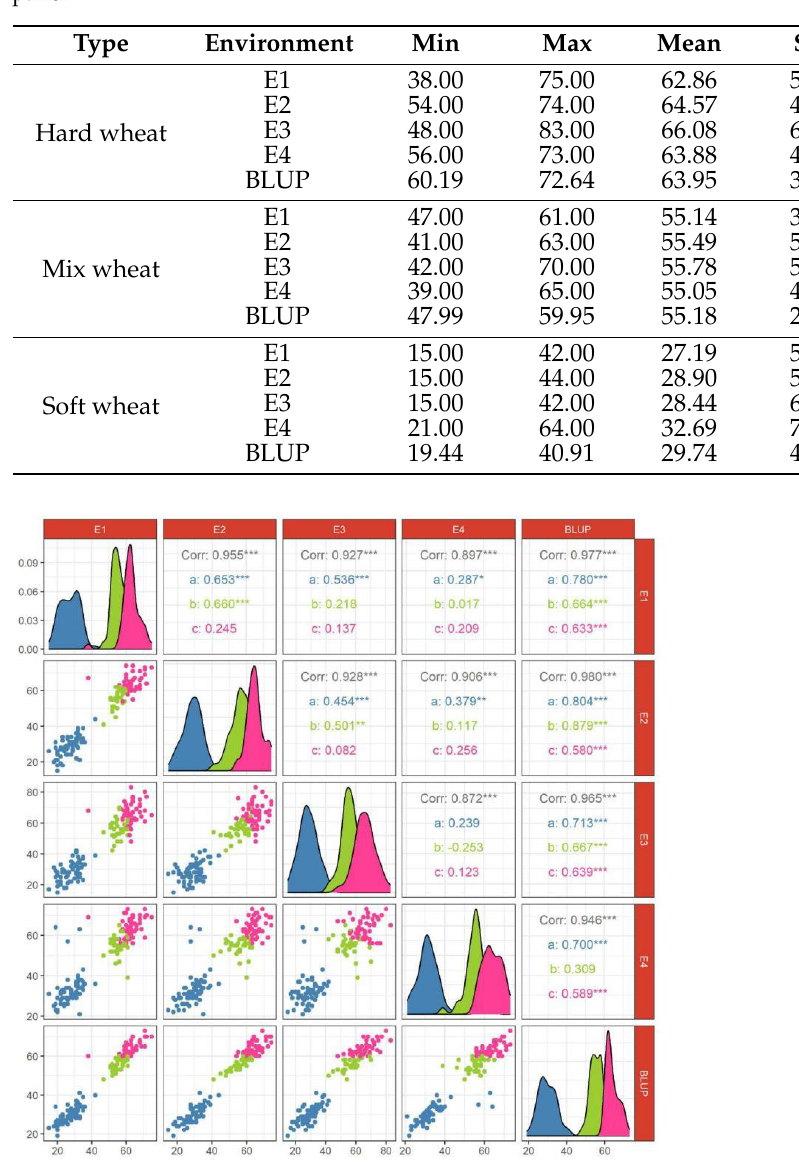
Table 1. Descriptive statistics of three types of wheat in different environments in the association panel.